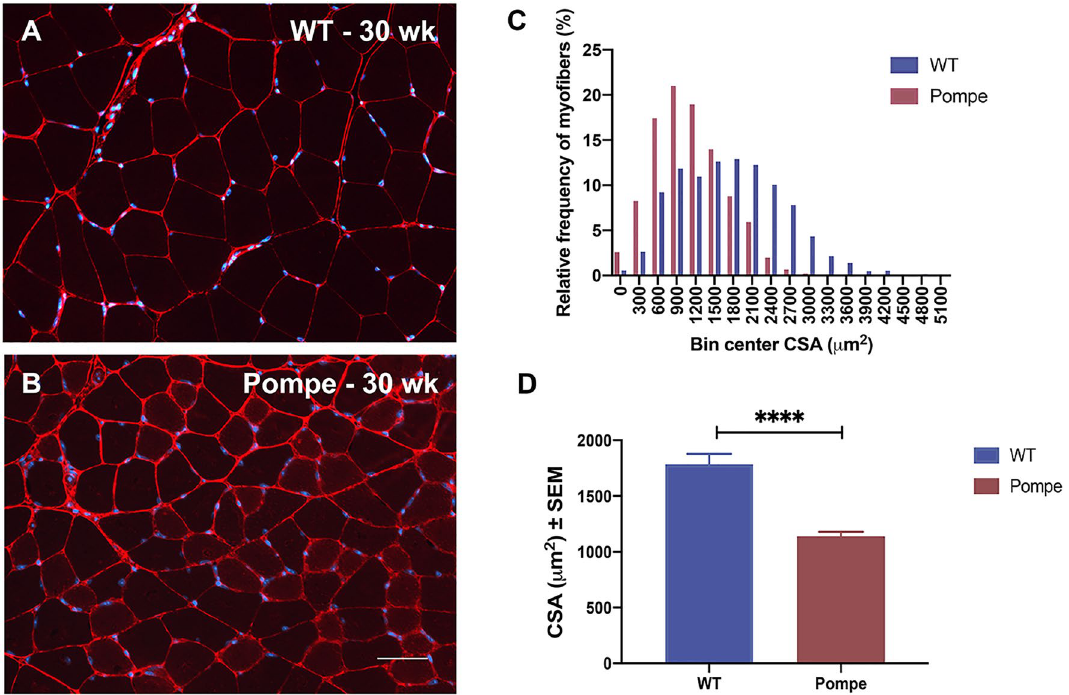
Figure 2. Histological analysis of myofiber CSA in WT and Pompe mice. Representative images of gastrocnemius (GA) muscle histology (stained with Collagen VI (red, cell membranes) and DAPI (blue, nuclei) for WT ( A ) and Pompe ( B ) mice at 30 weeks. The corresponding frequency distributions of the GA cross- sectional areas (CSA) from Pompe (N = 4097 fibers) and WT (N = 2678 fibers) are shown in the histogram ( C ). Note the major shift to smaller size fibers in the Pompe animals (Mean = 1125 ± 9) as compared to WT (Mean = 1740 ± 16) mice. ( D ) Mean GA muscle myofiber CSA in WT and Pompe mice at 30 weeks, reported as mean ± SEM. (Unpaired t-test). * p < 0.05; ** p < 0.01; *** p < 0.001; **** p < 0.0001; ns not significant. Scale bar = 50